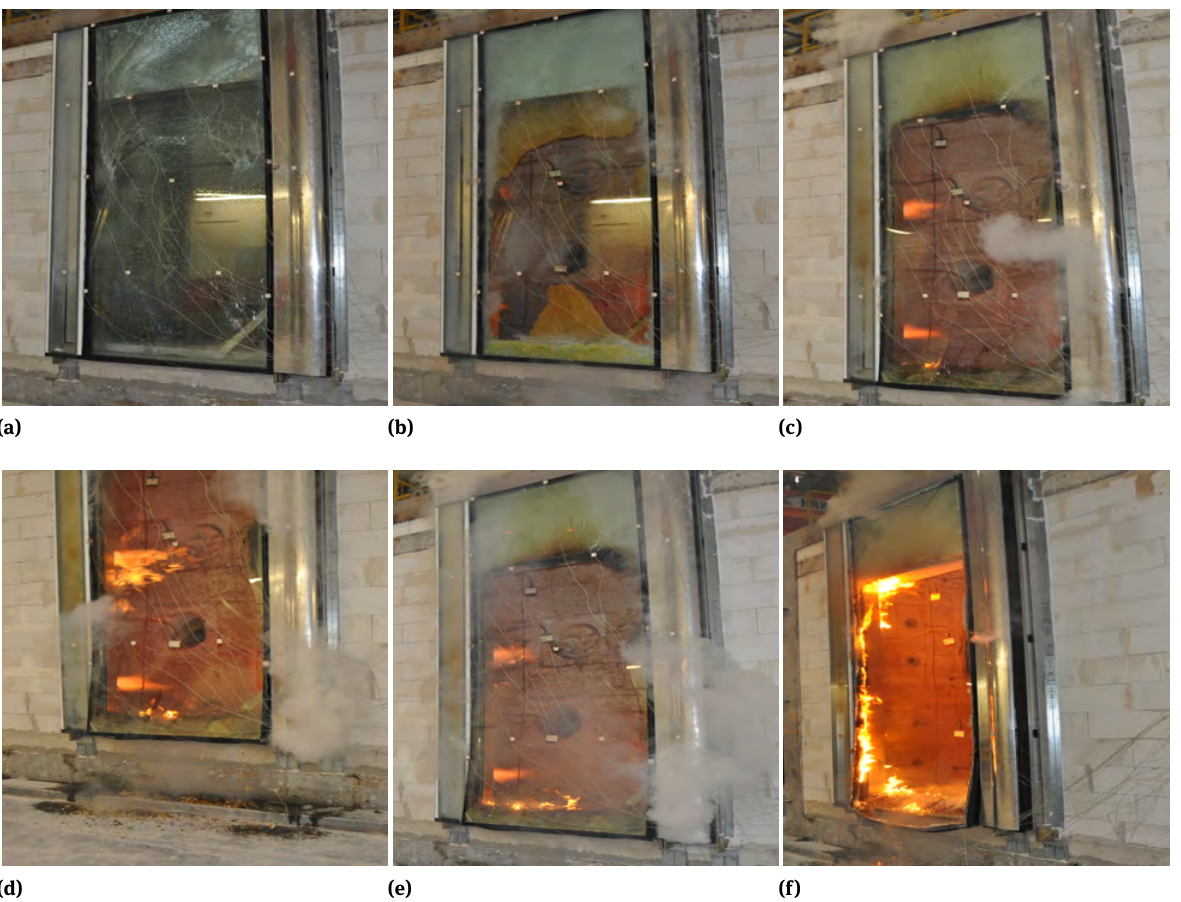
Figure 12: The view of the unexposed surface of tested specimen: a) in 4’50” of the test; b) in 6’49” of the test; c) in 10’04” of the test, d) in 12’27” of the test; e) in 12’29” of the test; f) after the test. 415–422. DOI: